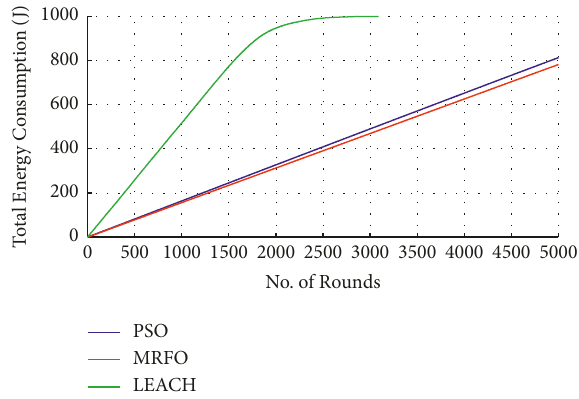
Figure 15: Total energy consumption or 500-node network, 50 CHs when the BS is at the center of